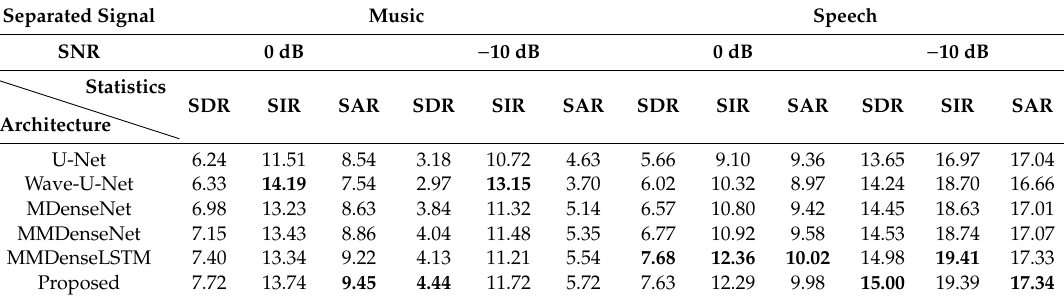
Table 3. Separation results (dB) on broadcast